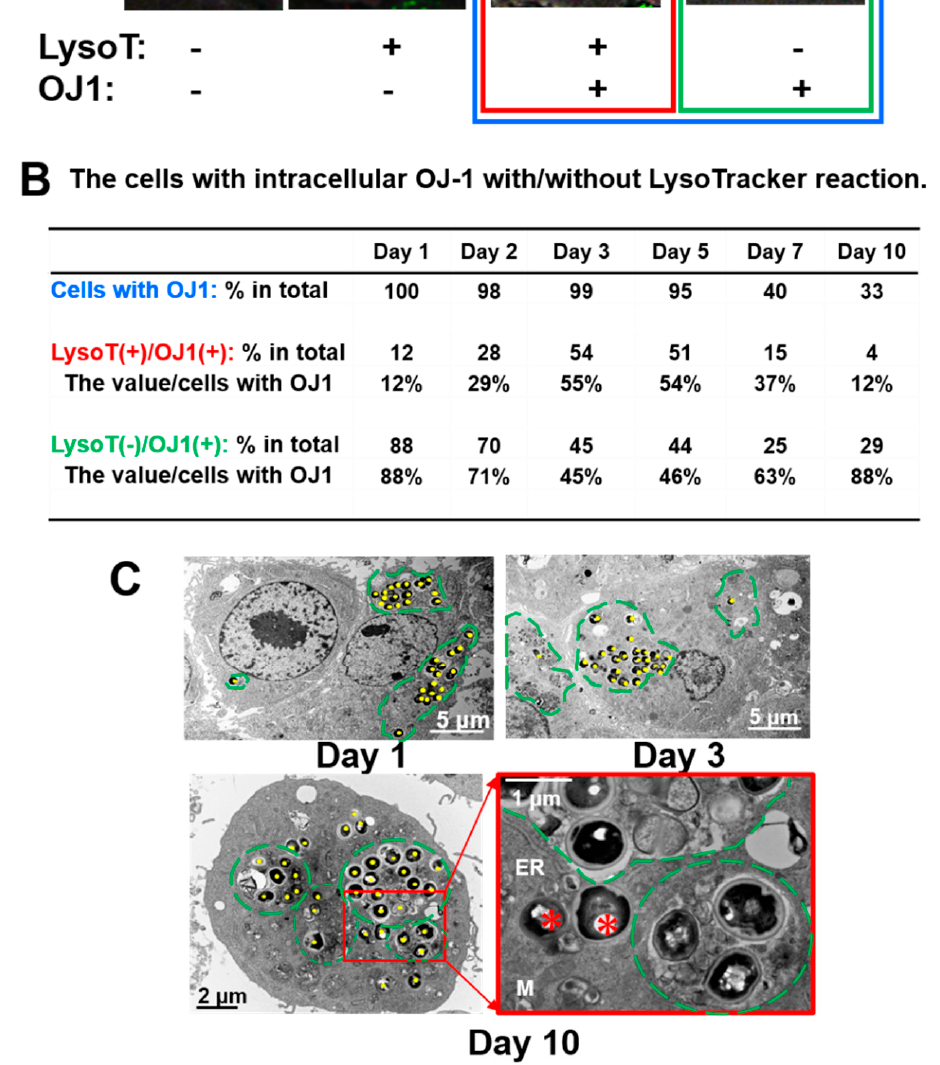
Figure 5. Intracellular OJ-1 and LysoTracker-positive lysosome. ( A ) In the AV group, four different cell types appeared based on the presence/absence of LysoTracker-positive (LysoTpositive) lysosomes shown in red and intracellular OJ-1 shown in green: LysoT( − )/OJ-1( − ), LysoT( − )/OJ-1(+), LysoT(+)/OJ-1( − ), and LysoT(+)/OJ-1(+), respectively. ( B ) The cells with intracellular OJ-1 were analyzed on the presence or absence of LysoTpositive lysosomes during 10 days of incubation. Values are the mean of triplicated data. ( C ) Ultrastructure of J774A cells after ingesting OJ-1. Morphological alterations of J774A cells in the AV group were examined on days 1, 3, and 10 after ingesting OJ-1. Bacteria are labeled with yellow dots. Clusters of bacteria are surrounded by the lysosomal compartments (green lines) in the cells on days 1, 3, and 10. However, on day 10, some bacteria (*) escaped from the lysosome and localized in the cytoplasm, where mitochondria (M) and endoplasmic reticulum (ER) are